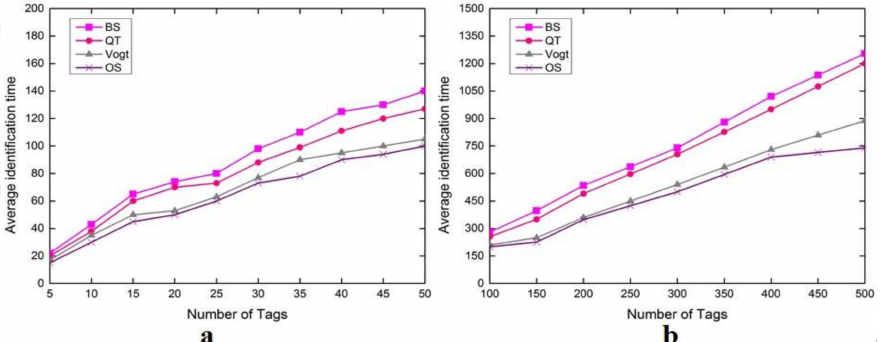
Figure 3. Comparison of the average identification time of four anti-collision schemes: BS, QT, Vogt and OS. ( a ) Number of tags in the range 5–50; ( b ) number of tags in the range